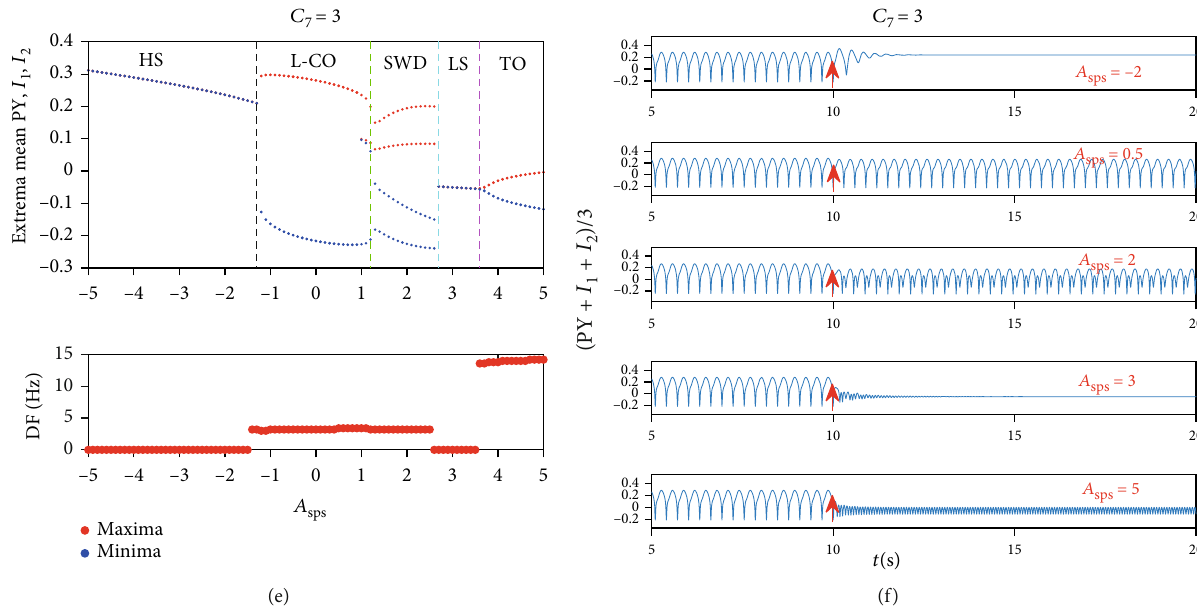
Figure 6: The bifurcation diagram (upper panel of (a), (c), and (e)), their corresponding dominant frequencies (lower panel of (a), (c), (e)), and the speci fi c time series (b, d, f) after single-pulse stimulation acting on RE at t = 10 s when the system is in SWD (a, b), tonic (c, d), and low frequency clonic (e, f) originally. For clarity, TO (tonic), SWD, LS (low saturated state), HS (high saturated state), l-CO (low-frequency clonic oscillations), and the strength of stimulation ( A sps ) are indicated by text labels in each fi gure.